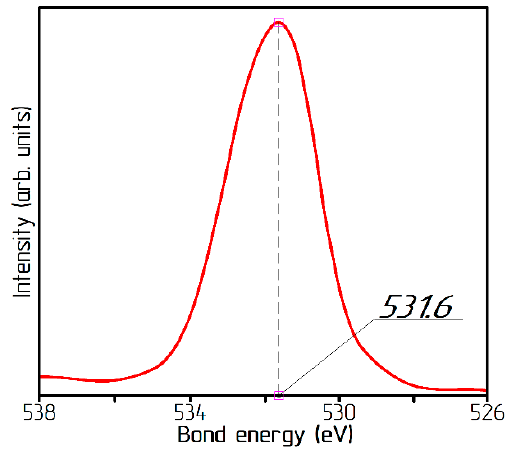
Figure 9. O1s spectrum.